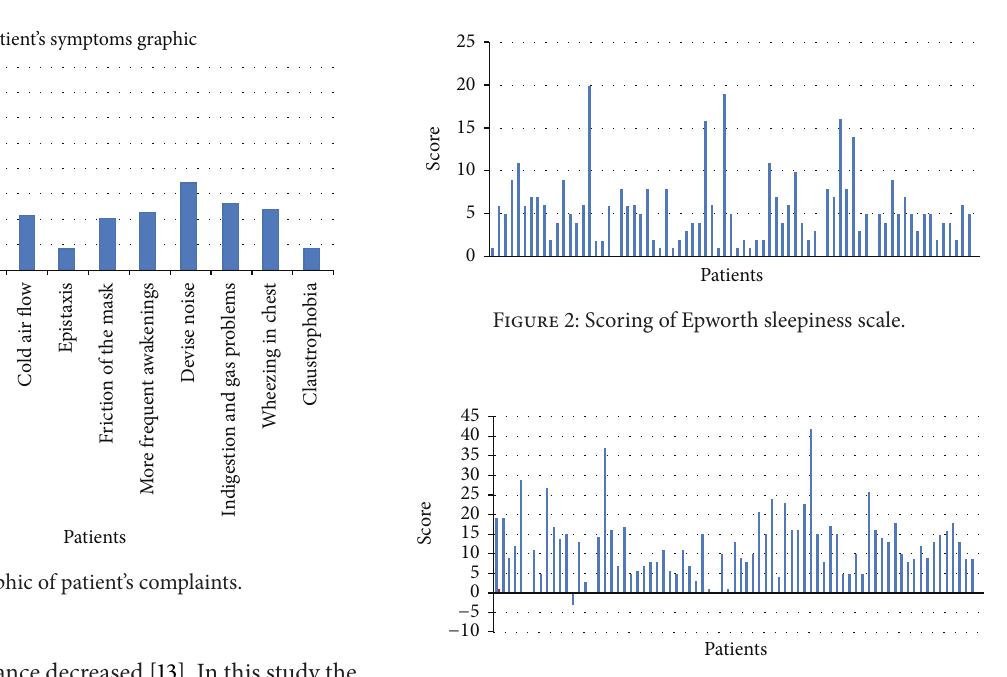
Figure 3: Alterations of OSAS symptoms after PAP treatment by using the scoring in Table